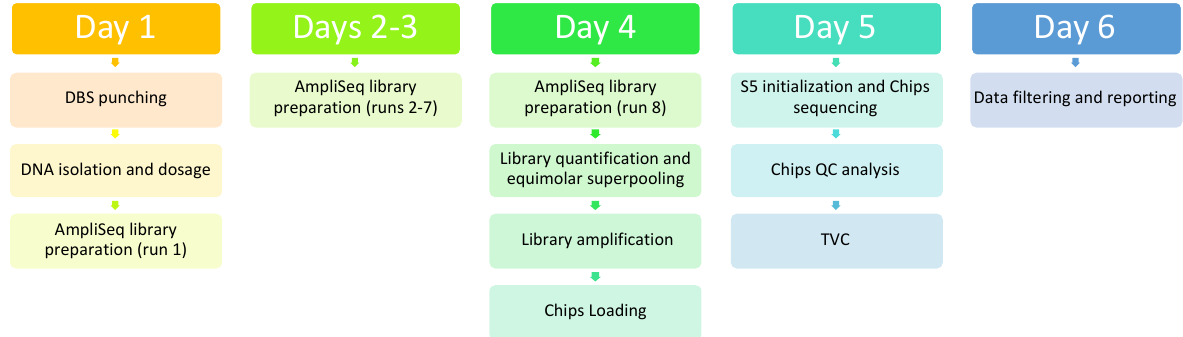
Figure 3. Turnaround time for processing 64 samples, from DBS (dried blood spots) punching and DNA isolation to filtering of relevant variants.